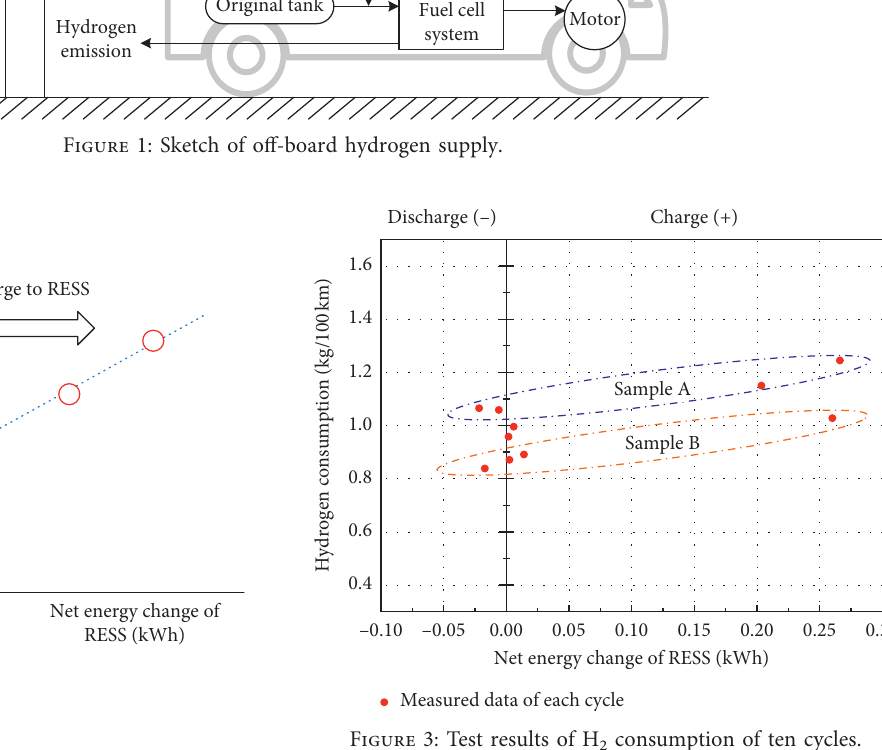
2 consumption of ten